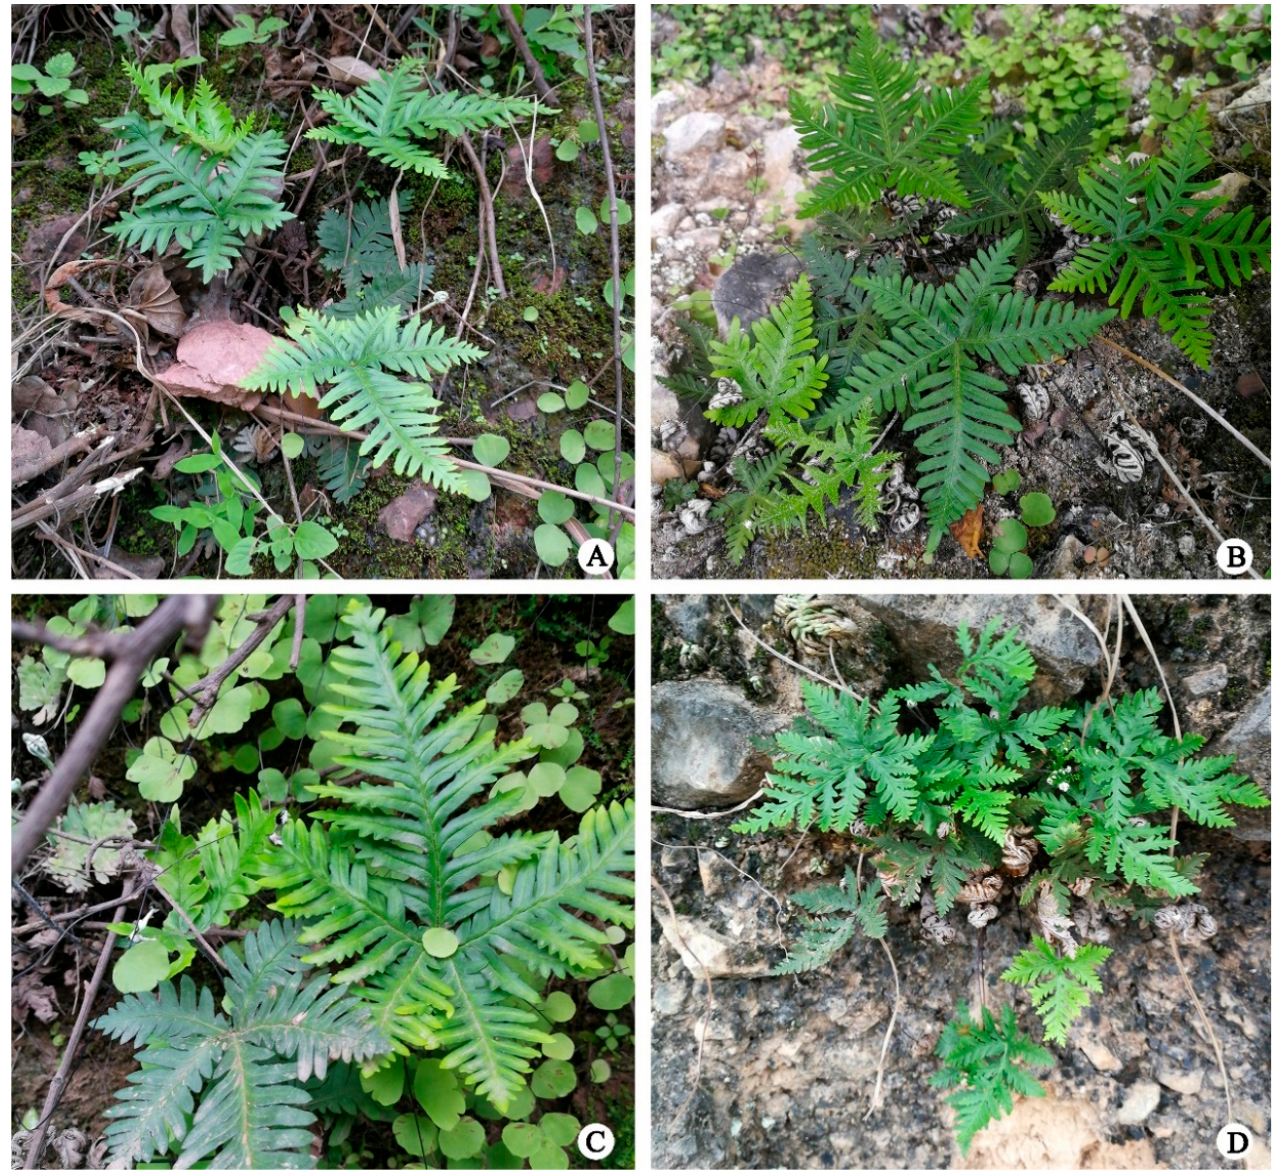
Figure 6. Photographs of A. grevilleoides and A. albofusca phenotypes in the wild population: ( A ) QH group ( A. grevilleoides , fern09010); ( B ) KM group ( A. grevilleoides , fern09033); ( C ) TD group ( A. grevilleoides , fern09025); ( D ) ST group ( A. albofusca , fern09032).